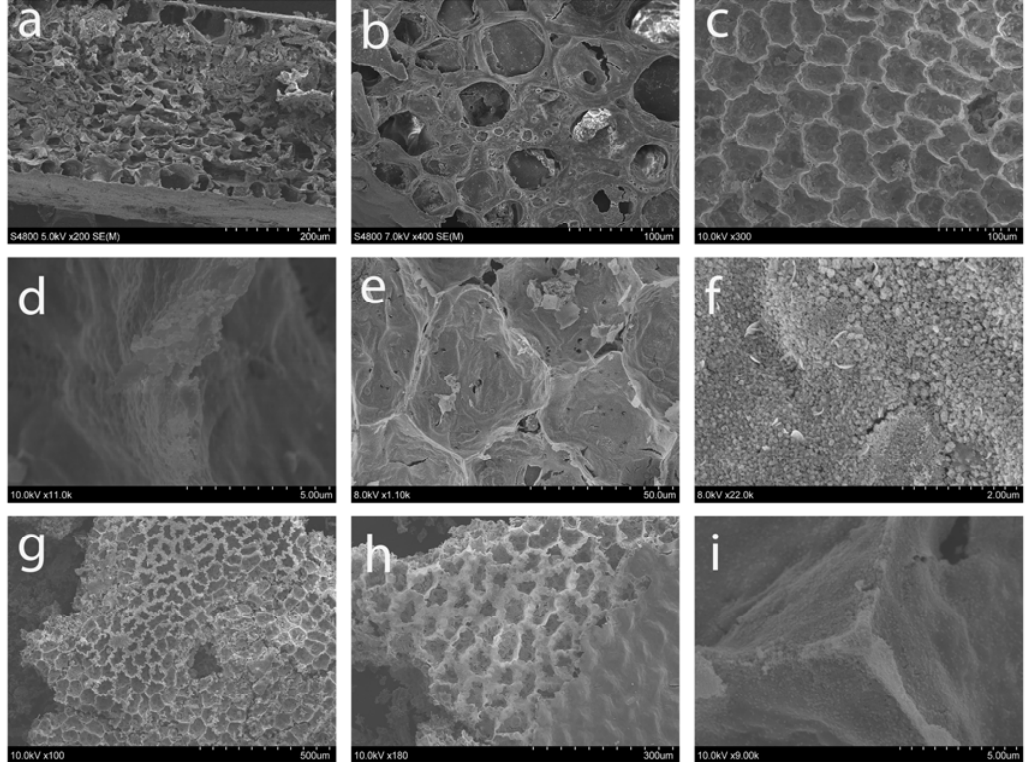
Figure 7. SEM images of ( a , b ) dehydrated ZZ leaf template; ZZ-ZnO ( c ) cellular view and ( d ) close-up wall view; Co(5%):ZnO ( e ) cellular view and ( f ) granular wall image; ( g , h ) Ni(10%):ZnO cellular view; and ( i ) Ni(5%):ZnO close-up view of cell wall intersection point.